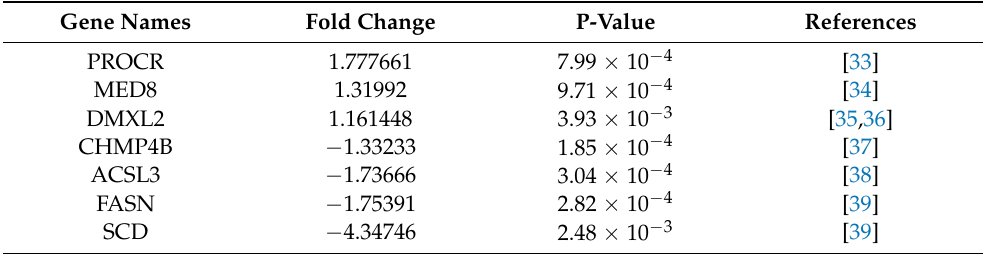
Table 1. CSC-related genes involved in Efavirenz-induced cancer responses for triple-negative